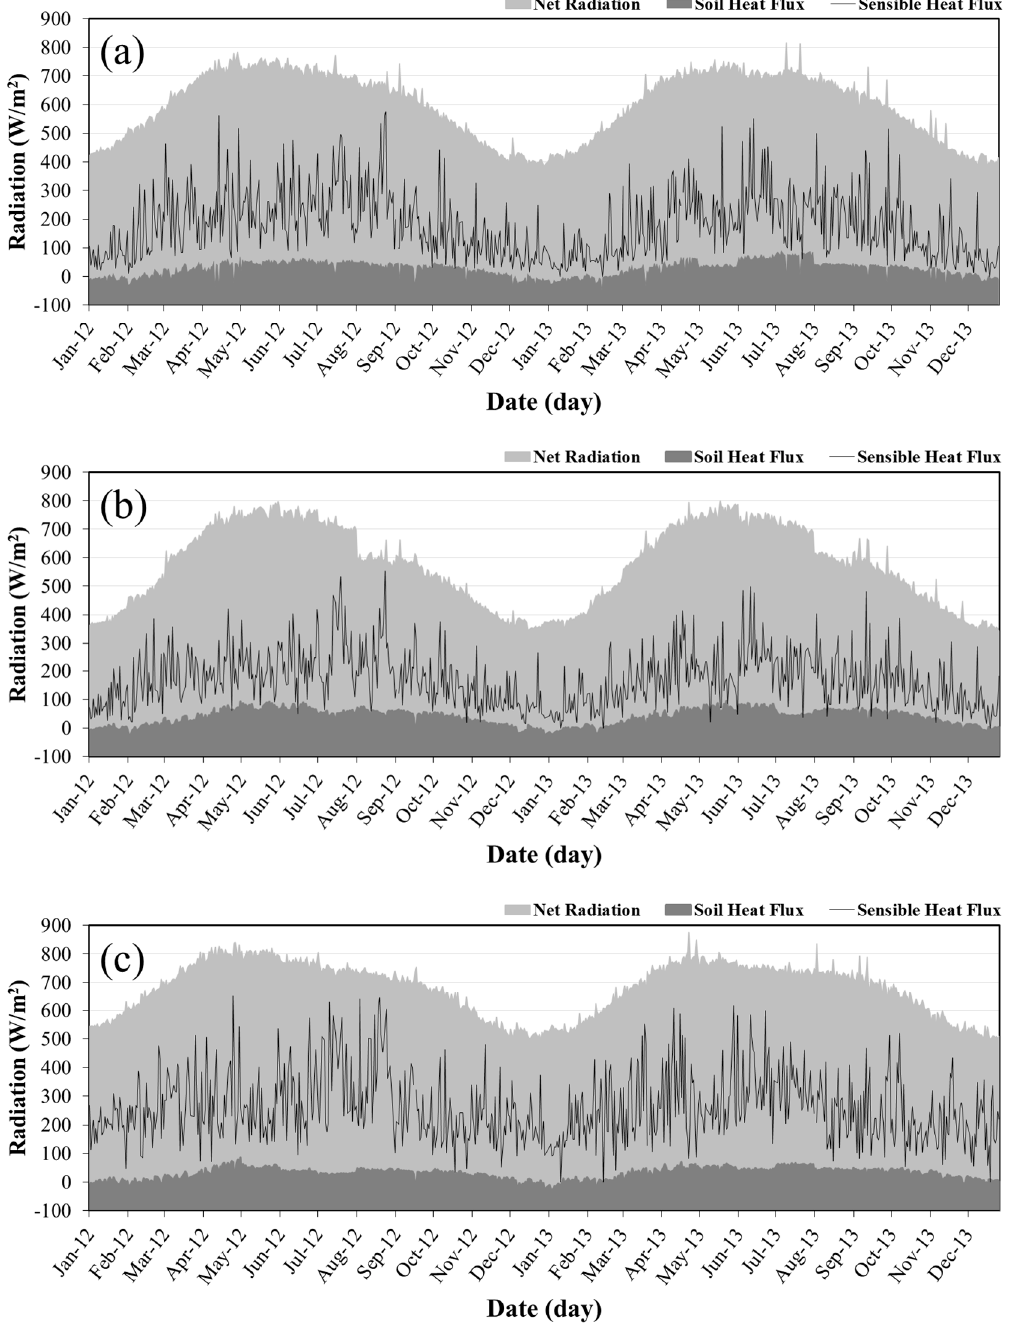
Figure 5. Time series of energy balance component at the three flux towers: ( a ) SMK; ( b ) CFK; and ( c ) DMK.